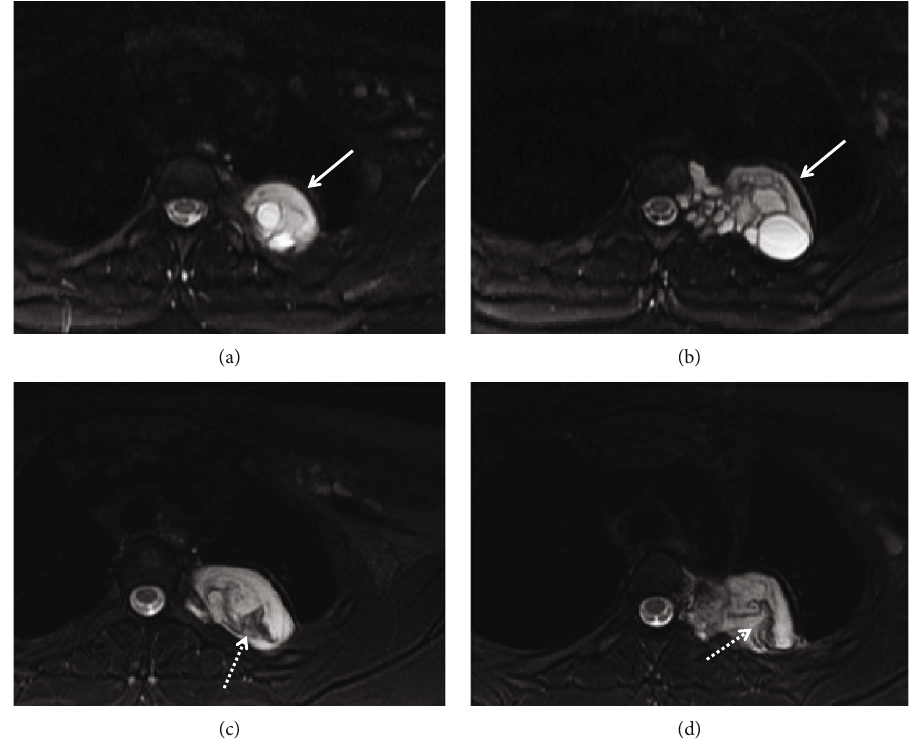
Figure 4: Axial T2-weighted images before medical treatment (a, b) show the left paravertebral hydatid cyst with numerous daughter cysts (arrows). Axial T2-weighted images postmedical treatment (c, d) show interval rupture of the daughter cysts and visualization of fl oating membranes (dashed arrows); these fi ndings are compatible with contained